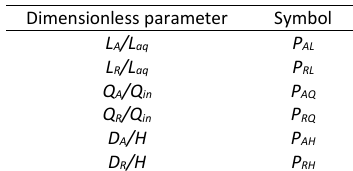
Table 3: List of dimensionless parameters introduced in ADR method Table 3. List of dimensionless parameters introduced in ADR